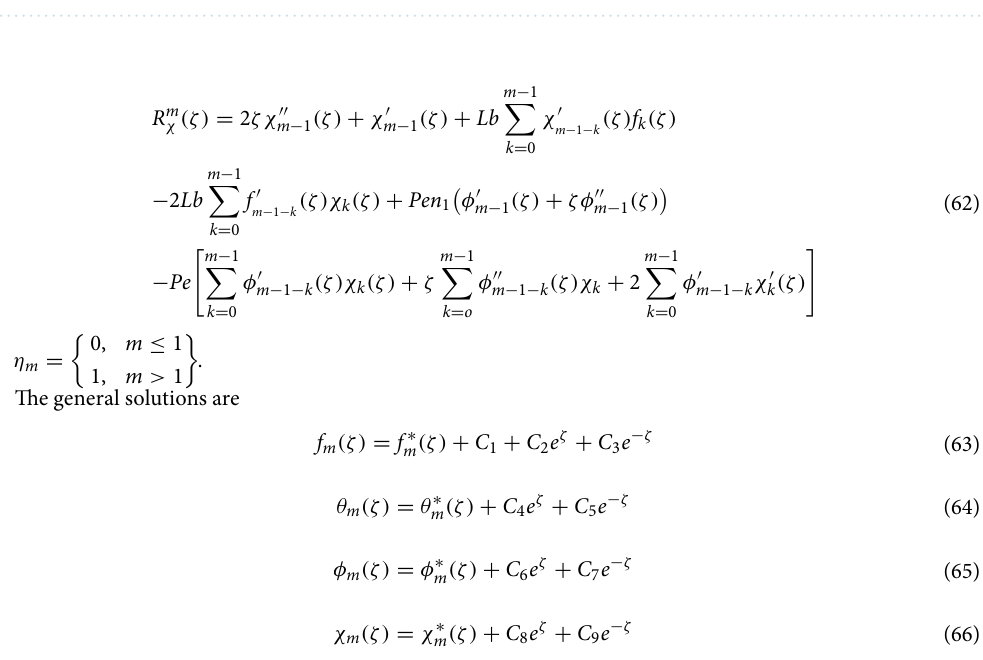
Figure 2. Spray rate as a function of β 1